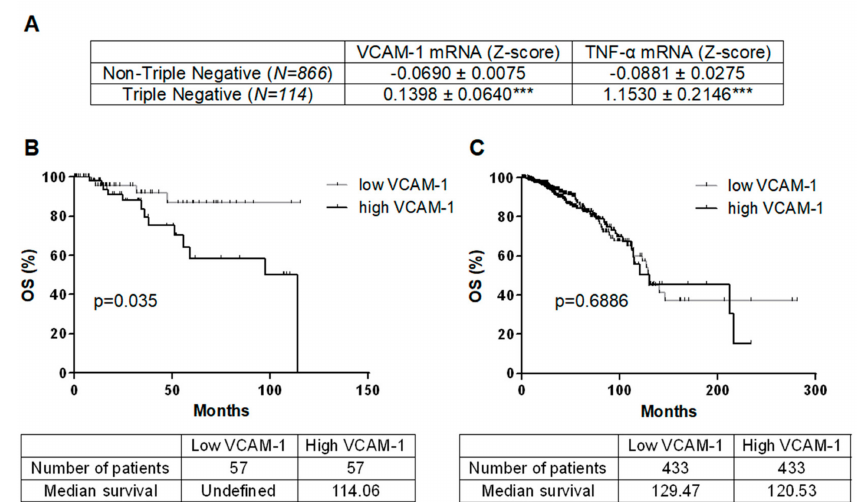
Figure 1. VCAM-1 is overexpressed in Triple-Negative Breast Cancer (TNBC) and associated with a decrease of overall survival. ( A ) Expression of VCAM-1 and TNF- α in TNBC and Non-TNBC were compared in TCGA datasets for breast cancer. Values represent the z scores for log 2 -transformed normalized RNA-seq read counts. ( B , C ) Kaplan-Meier analysis of OS of TNBC ( B ) and Non-TNBC ( C ) patients. OS (months) were calculated from patient subgroups with VCAM-1 mRNA levels that were less or greater than the median value. Statistical significance ( p -value) is indicated. *** p < 0.001. Nb: Number.